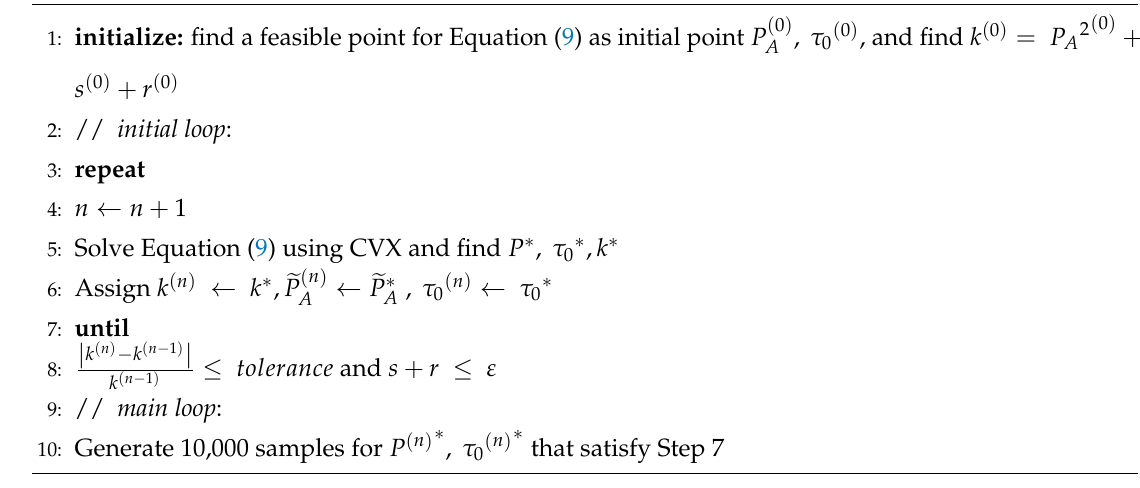
Algorithm 1 Sequential parametric convex approximation (SPCA)-based iterative algorithm to generate data for a single